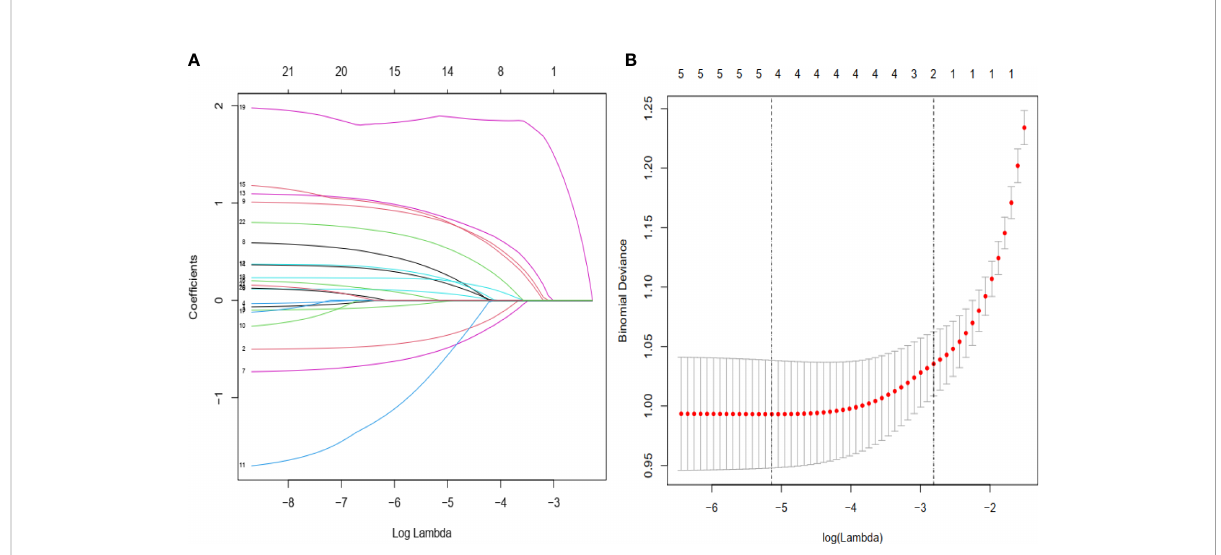
FIGURE 1 Demographic and clinical feature selection using the LASSO binary logistic regression model. (A) Twenty-two characteristic pro fi les of the LASSO coef fi cient. According to the logarithmic (lambda) sequence, a coef fi cient pro fi le was generated. The optimal lambda produced 15 non- zero coef fi cients. (B) The optimal parameter (lambda) in the LASSO model was selected via 10-fold cross-validation using minimum criteria. The partial likelihood deviation (binomial deviation) curve relative to log (lambda) was plotted. A virtual vertical line at the optimal value was drawn using one SE of minimum criterion (the 1-SE